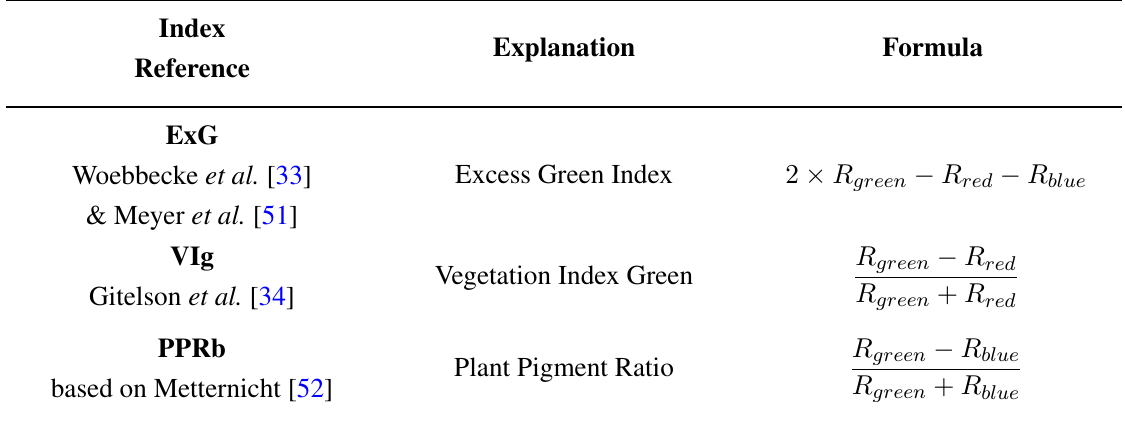
Table 2. Vegetation indices applied on the RGB images for pixel based crop/soil separation. The Excess Green Index (ExG) accounts for a combination of green and red, as well as green and blue reflection differences. The Vegetation Index Green (VIg) (sometimes also referred to as the Normalized Green-Red Difference Index (NGRDI)) represents a normalized green and red difference, whereas the adapted broadband variant of the Plant Pigment Ratio (PPRb) makes use of a normalized green and blue